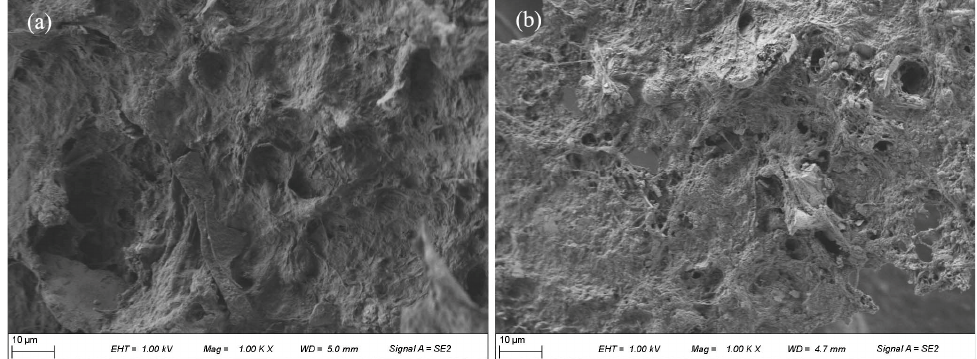
Figure 6. SEM of ( a ) raw sludge and ( b ) treated sludge. Conditions: Initial pH = 6.8, KIO 4 = 1.4 mmol/g VSS, Fe( Ⅱ )/KIO 4 molar ratio = 1.2.